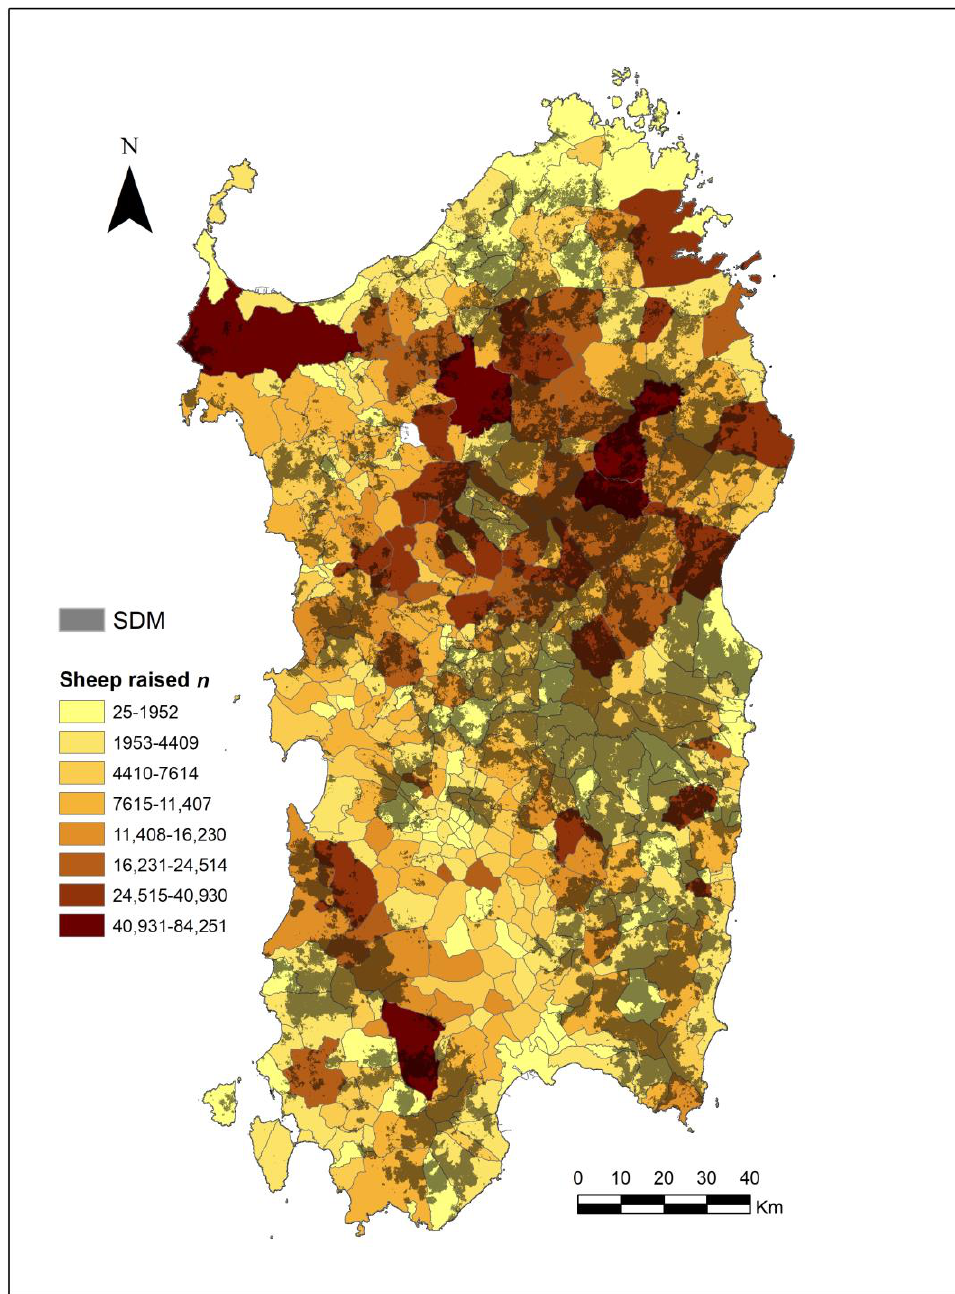
Figure 4. Corsican red deer SDM and distribution (at municipality level) and number of domes- tic